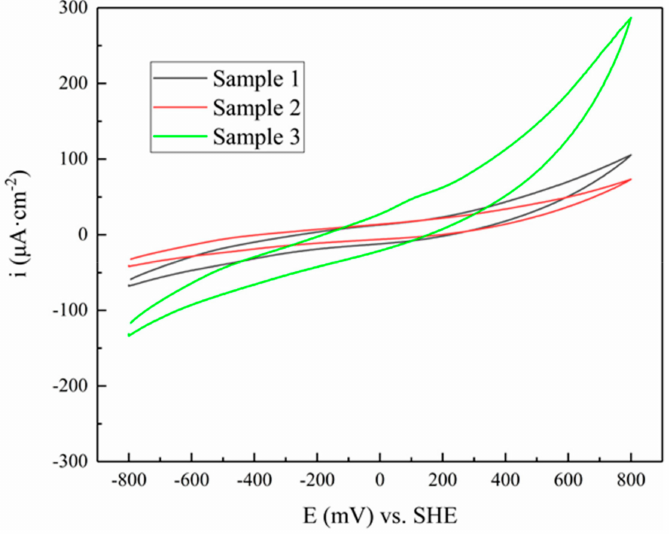
Figure 9. Cyclic voltammogram curves of the three samples in a solution with a xanthate concentration of 6 × 10 − 5 mol / L at a scan rate of 20 mV /